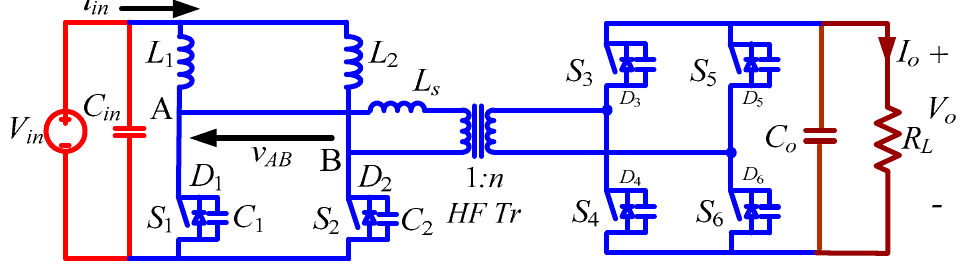
Figure 1. The zero current switching (ZCS) naturally clamped current-fed half-bridge isolated DC-DC converter. Reproduced with permission from [17], IEEE, 2020.